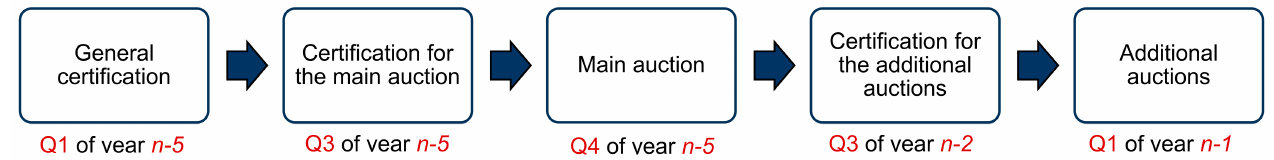
Figure 2. Main stages of the participation process in the capacity auctions for the n –delivery year. Source: Own analysis based on